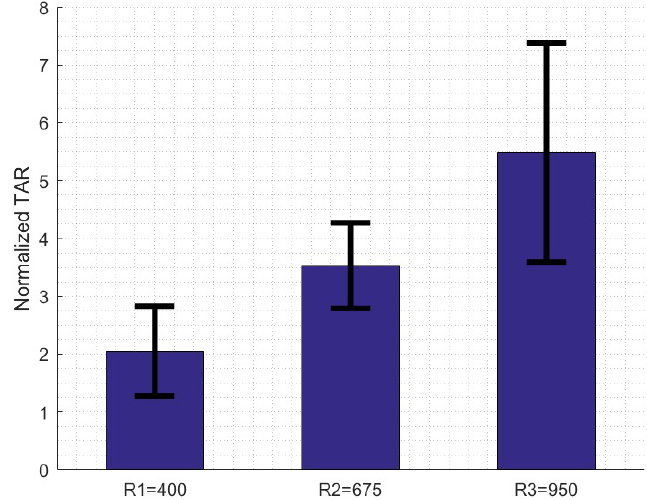
Figure 7. Normalized TAR as a function of the radius.